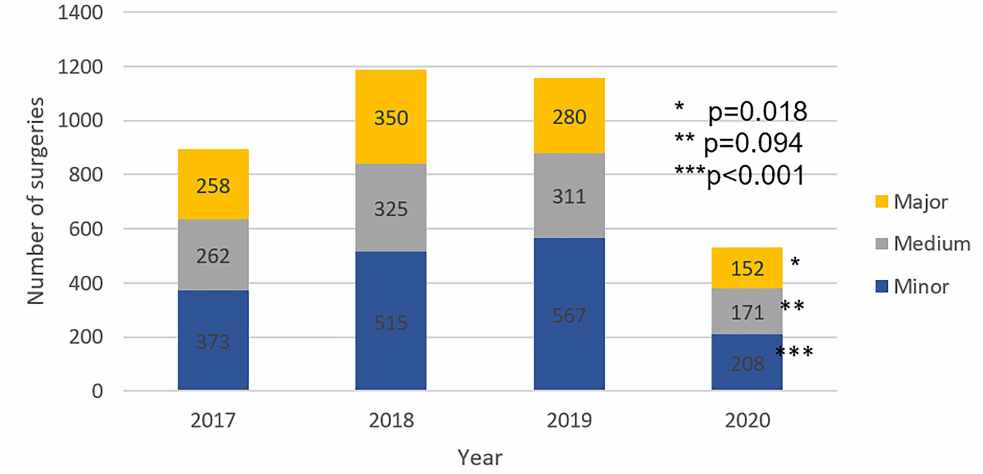
Figure 1 - Comparison of surgical volume categorized by complexity from February 27th to May 30 th